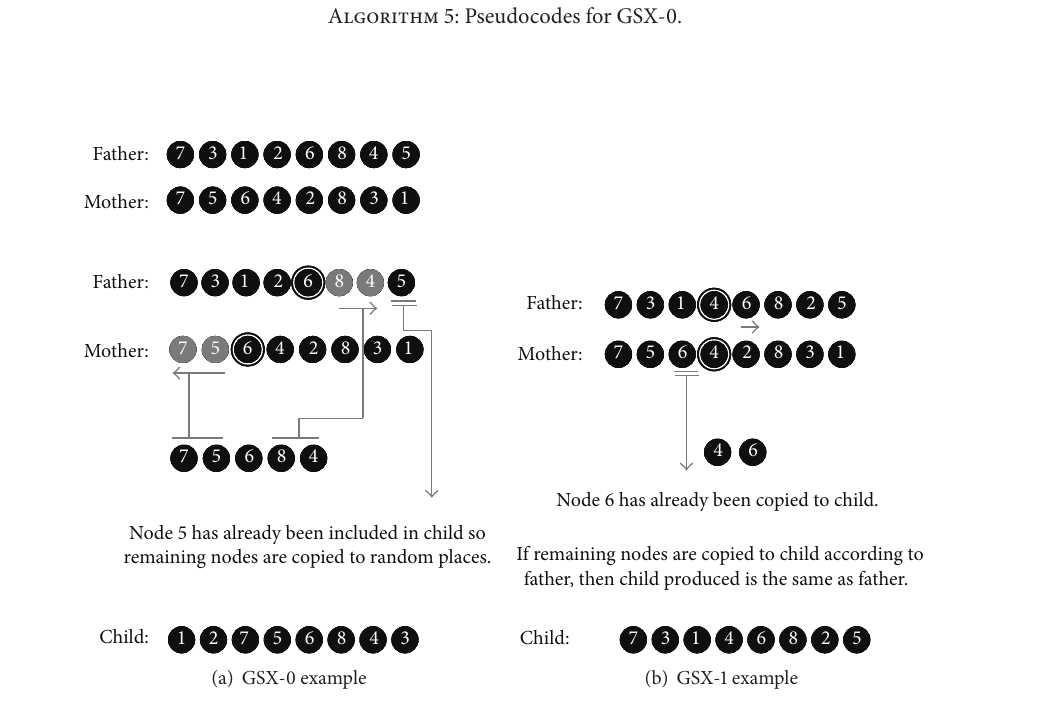
Figure 3: Examples for GSX-0 and